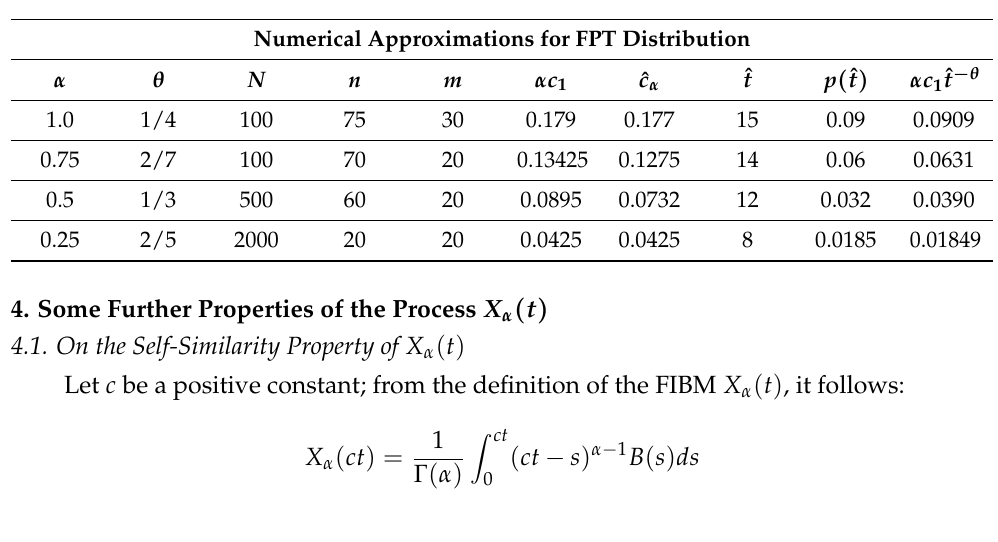
Table 2. For the specified values of fractional order α , we report the following: the conjectured persistence exponent θ , the number N of trials, the number n for the evaluation of the maximum as in (23), the number m of nodes of the quadrature as in (22), the product α c 1 , the estimate ˆ c α as in (24), the time value ˆ t in which the probability is computed, the approximate probability p ( ˆ t ) and the expected (conjectured) value α c 1 ˆ t − θ